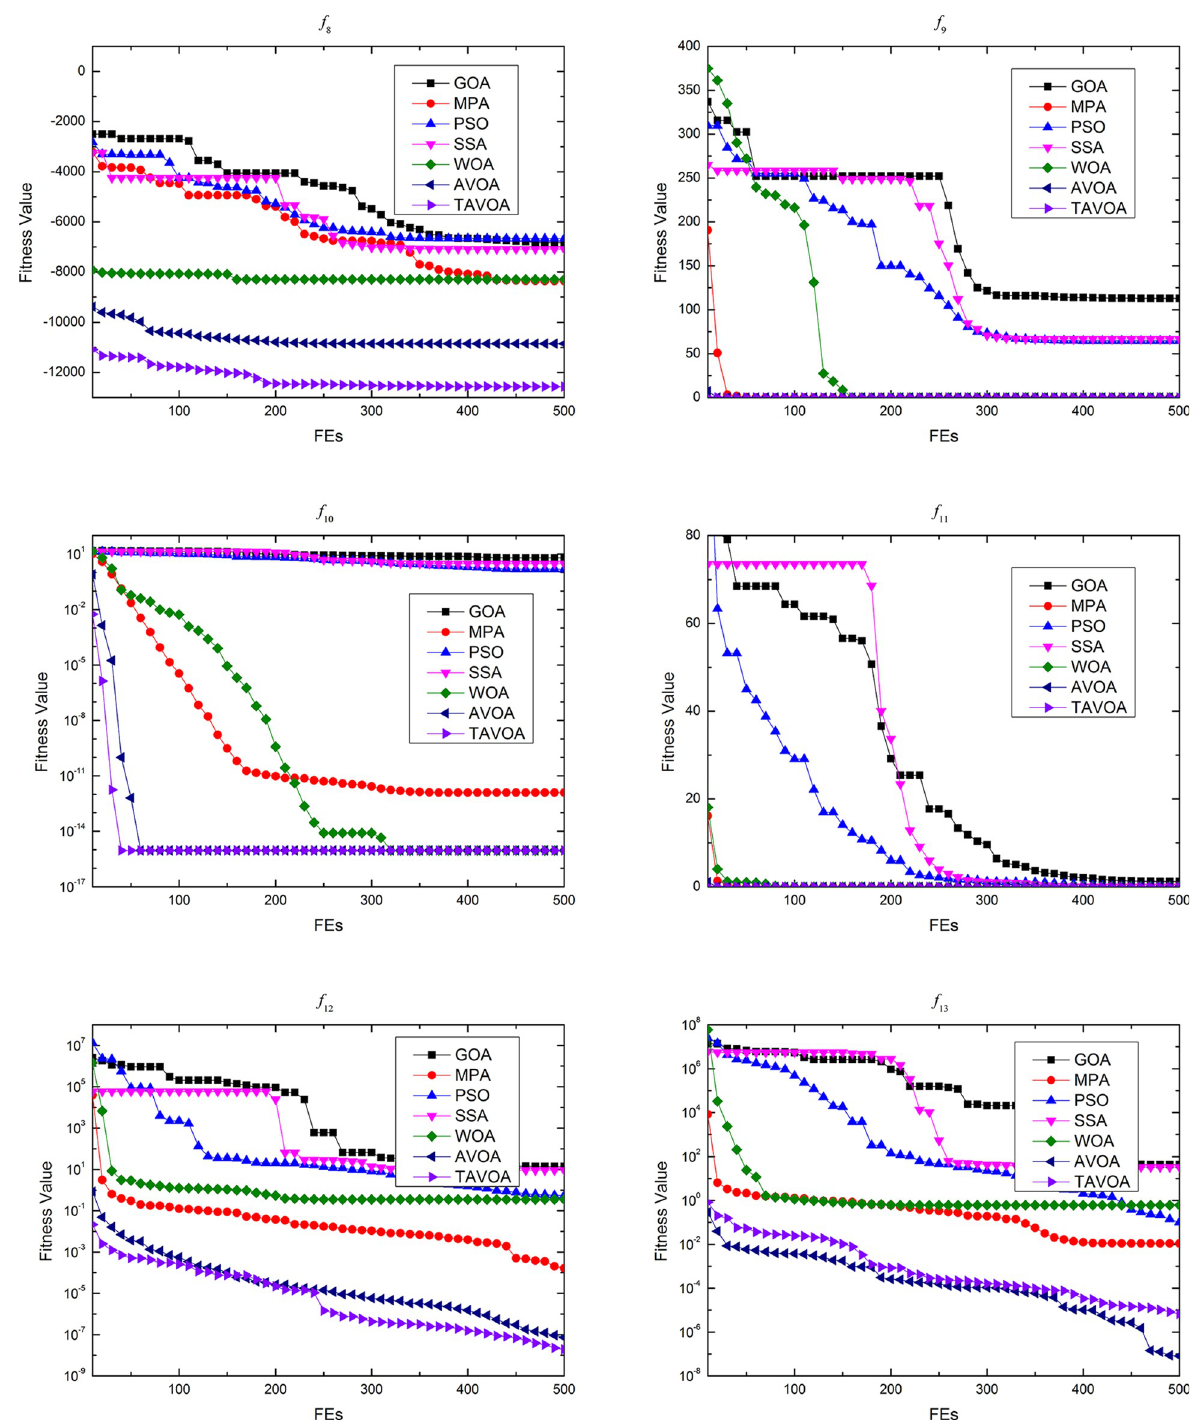
Fig 8. Convergence process on basic multi-modal benchmark functions.